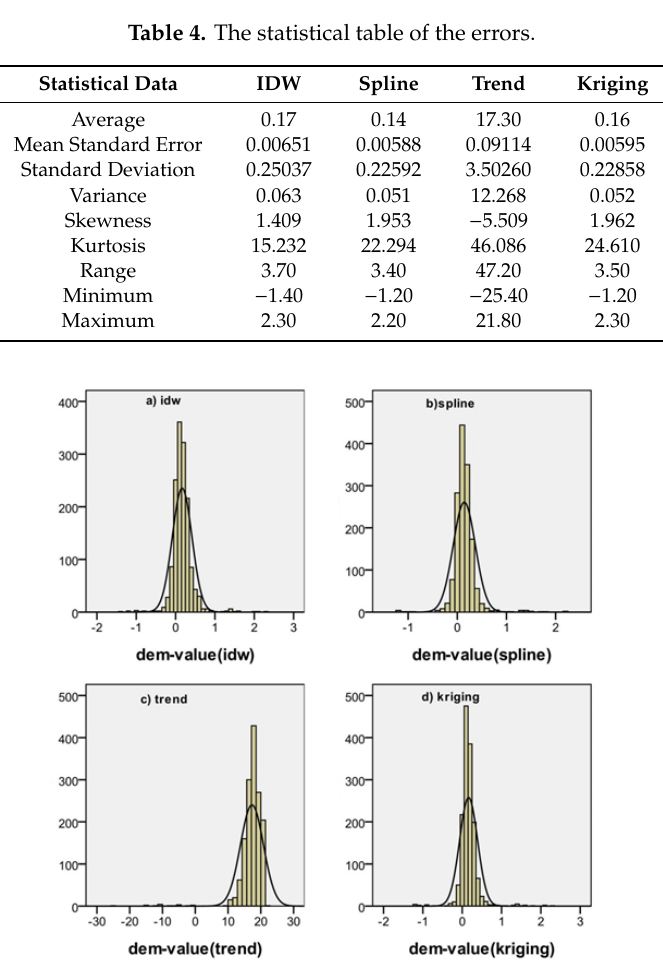
Table 3. The parameters used for the interpolation methods.